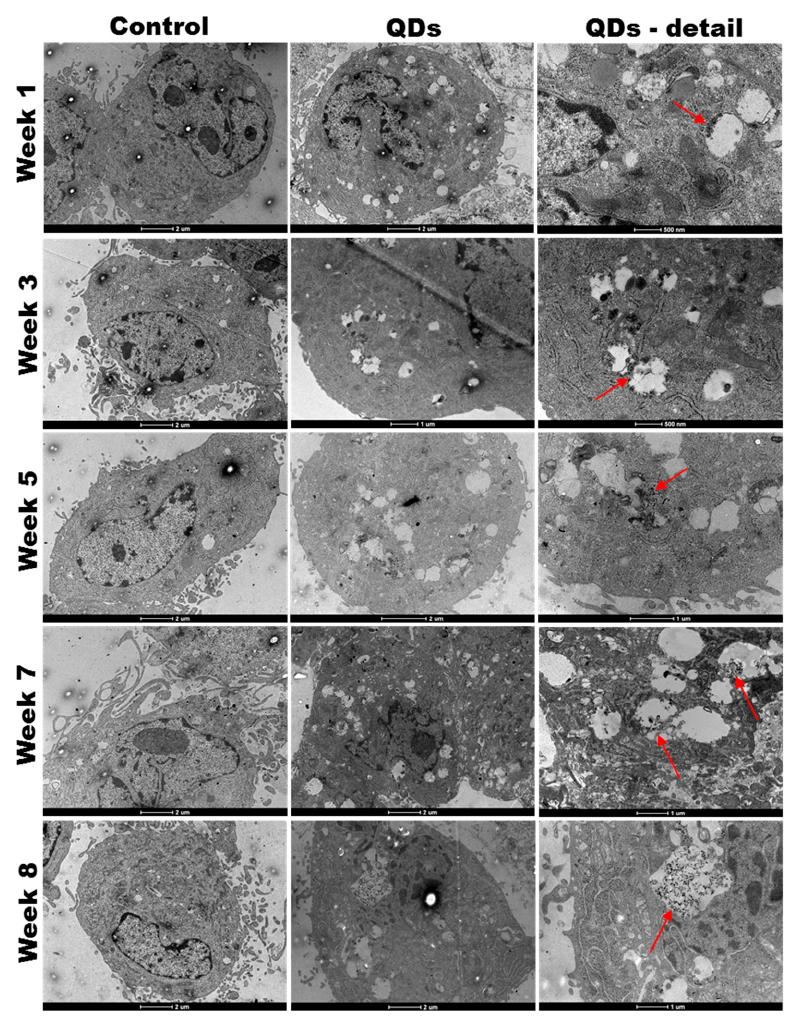
Figure 4. Ultrastructural appearance of MRC-5 human lung fibroblasts during the long-term exposure to Si/SiO 2 QDs in comparison with control cells. Note the progressive accumulation of QDs within membrane-bound structures inside the cells as highlighted by the red arrows.